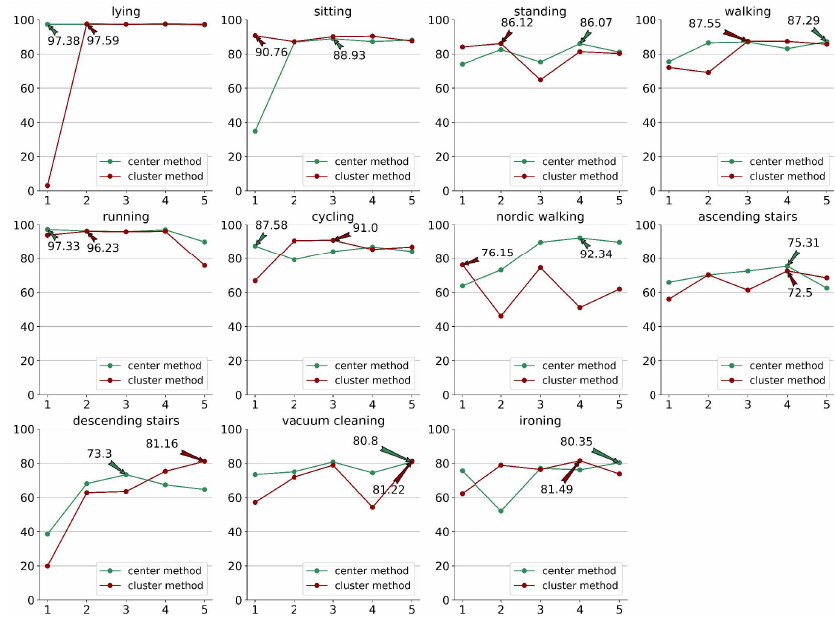
Figure 10. The F1-score (in percent) of each class in the PAMAP2 dataset evaluated by the CNN-M model for open-set human activity recognition. Among, the horizontal axis represents the number of chosen seed. The two lines represent the center and cluster methods. The markpoints of different lines represent the highest